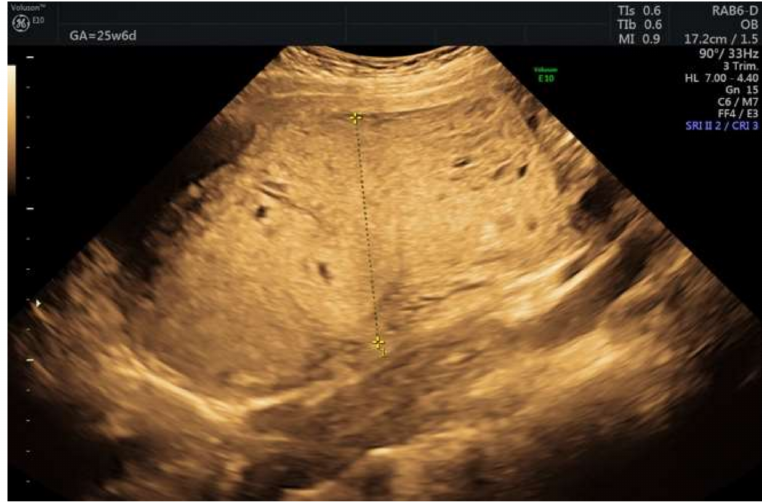
Figure 2. “Swiss-cheese” or “Moth-eaten” appearance of the placenta.